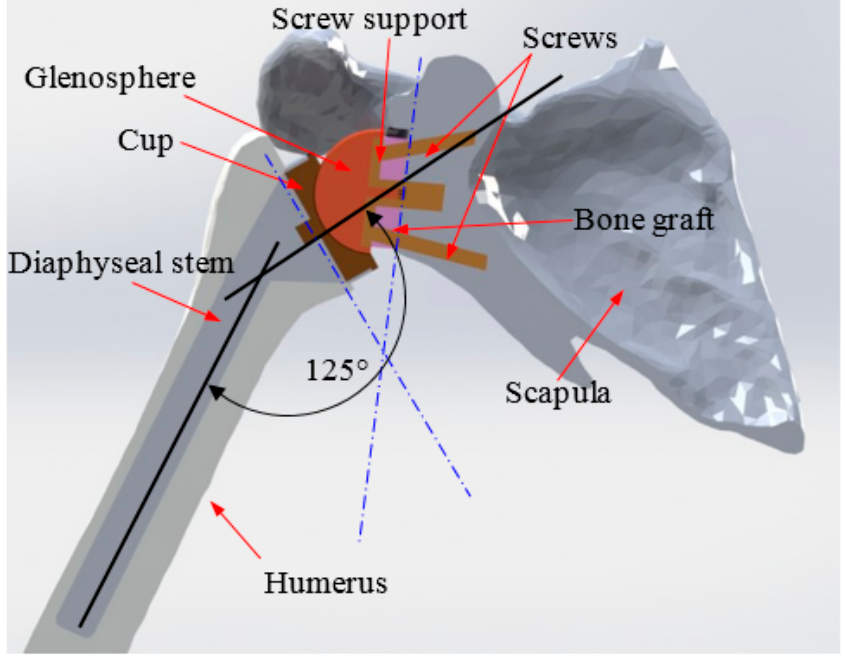
Figure 3. Implantation of the prosthesis into the shoulder joint.